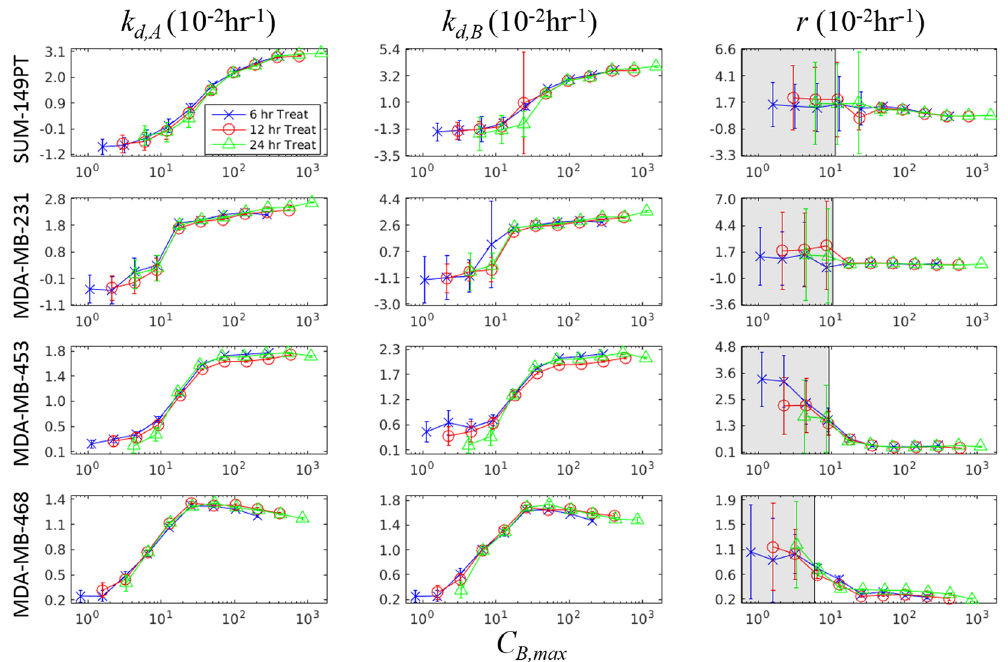
Figure 5. Parameter fits from Eq. (5) in a panel of TNBC cell lines as a function of C B,max . The parameters in Eq. (5) are fit to each treatment condition as described in Section 2.5 and plotted with 95% confidence intervals against the cell-line specific simulated C B,max from Eqs (1–3). The blue X’s, red O’s, and green Δ ’s represent the parameter fits extracted from the 6, 12, and 24 hour exposure time datasets respectively. Model parameters estimated from each exposure time appear to collapse on each other, when described by C B,max – a summary statistic of each treatment condition. This indicates that the compartment model is effective at describing the treatments. Further, given that each cell line appears to follow a single trajectory for each parameter, this model can be used to predict cell population response to any predefined input function. The gray areas for parameter r represent treatment ranges where the total-order sensitivity index ( S TI ), which describes the effect of parameter variation on model prediction variation, is ≤ 0.3. Thus the large variance in parameter estimates here has a limited impact on model